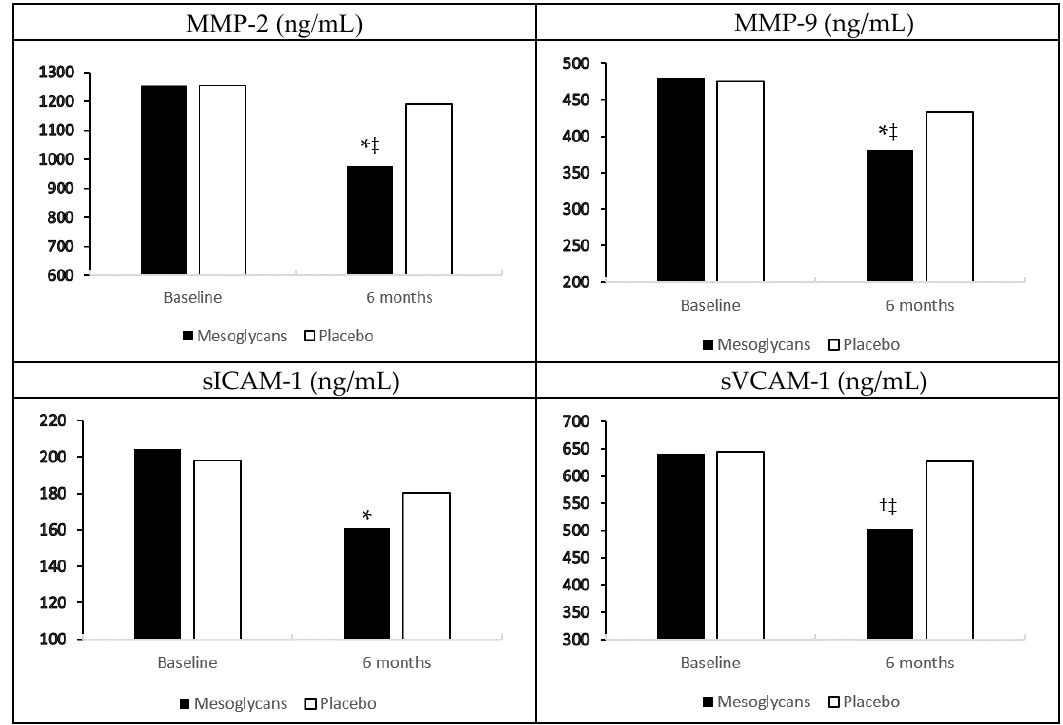
Figure 1. Endothelial damage biomarkers variation with mesoglycan and placebo. Data are expressed as mean ± standard deviation; * p < 0.05 vs. baseline; † p < 0.01 vs. baseline; ‡ p < 0.05 vs. placebo.